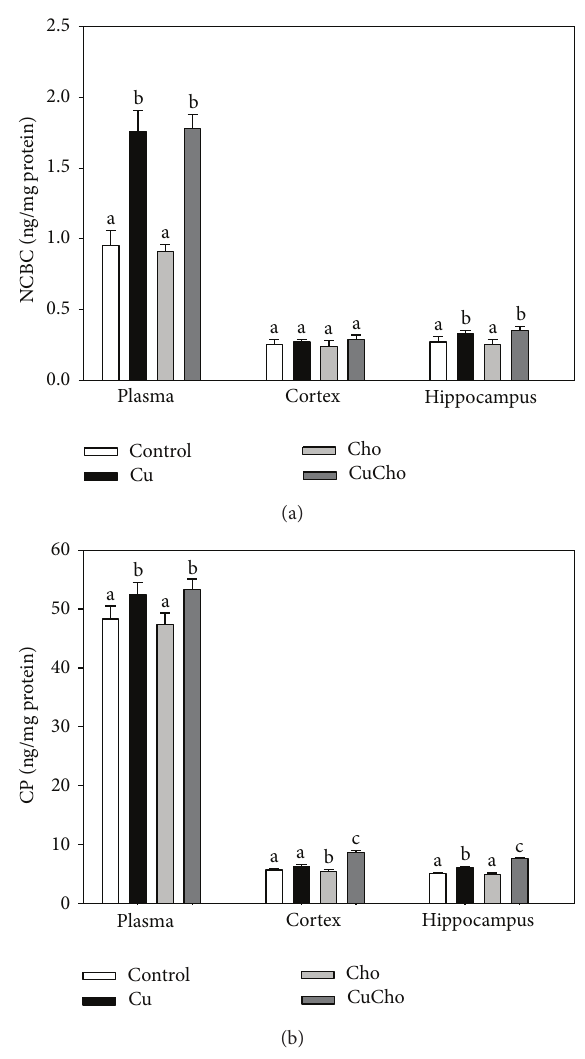
Figure 1: Free Cu (NCBC) (a) and ceruloplasmin (CP) (b) levels in brain cortex and hippocampus homogenates (ng/mg total protein). Treatments are indicated with different colors, control (white bars), Cu (black bars), Cho (gray bars), and CuCho (dark gray bars). Samples were analyzed as indicated in Sections 2.5 and 2.6. Results are expressed as mean of 10 rats assayed in triplicate ± standard deviation (SD). Significant differences among the experimental groups are indicated with superscript letters (values with distinct letters are significantly different between them, 𝑃 < 0.01 ).